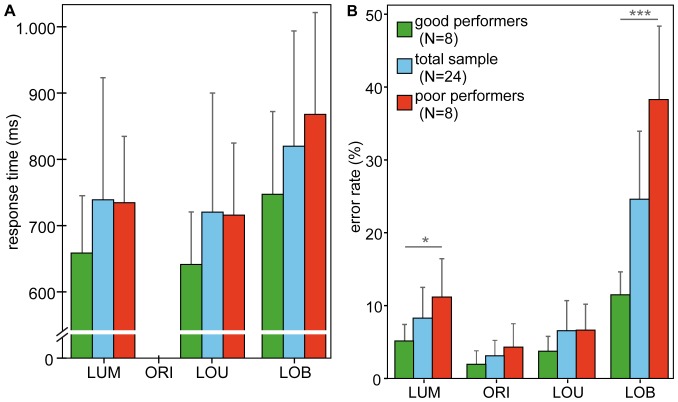
Behavioral results.Mean response times (A) and error rates (B) for the total sample (N = 24; shown in blue), good performers (N = 8; shown in green) and poor performers (N = 8; shown in red); error bars depict standard error. Both response times and error rates were highest on perceptual conflict trials (LOB) in comparison to non-conflict trials (LUM, ORI, LOU). Missing reaction times for the ORI condition indicate no-go trials subjects were instructed not to respond to.